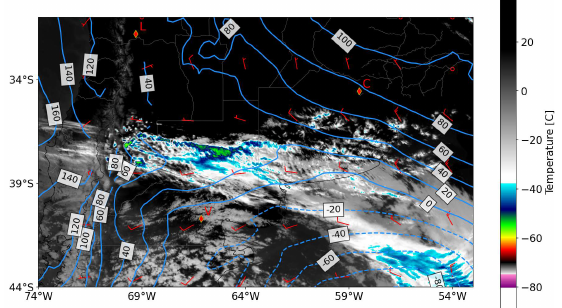
Figure 2: Image acquired from GOES 16 on 14 Decem- ber 2020 at 16 UTC. The image corresponds to chan- nel 10.33 mu m. The locations of CASLEO (L), CIT- EDEF(C) and Valcheta(V) are shown. The 1000 hPa isohypses are shown in light blue lines and the wind vec- tors (ms − 1 ) at the same level extracted from the ERA 5 reanalysis model for 16 UTC on the day of the eclipse are shown in